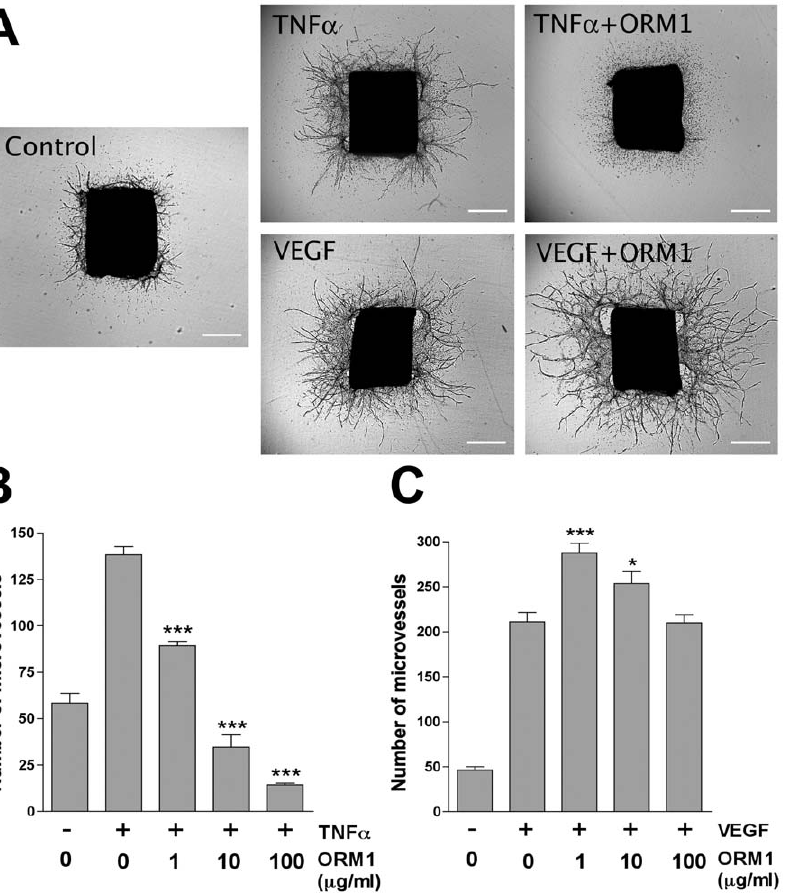
Figure 3. ORM1 differentially influences the effect of TNF a and VEGF on aortic angiogenesis. (A). Angiogenesis in aortic cultures is stimulated by both TNF a and VEGF (N=4; p , 0.001). TNF a (5 ng/ml) loses its pro-angiogenic activity and becomes inhibitory in the presence of ORM1 (100 m g/ml). Conversely ORM1 does not inhibit and instead enhances VEGF-stimulated angiogenesis (10 ng/ml). (B). TNF a progressively loses its capacity to stimulate angiogenesis in cultures treated with increasing doses of ORM1 and becomes potently inhibitory in the presence of 100 m g/ ml ORM1. (C) Increasing doses of ORM1 have no inhibitory effect on the pro-angiogenic activity of VEGF which is actually enhanced by 1–10 m g/ml ORM1. Magnification bars: 500 m m (A). N=4; *=p , 0.05; ***=p , 0.001.